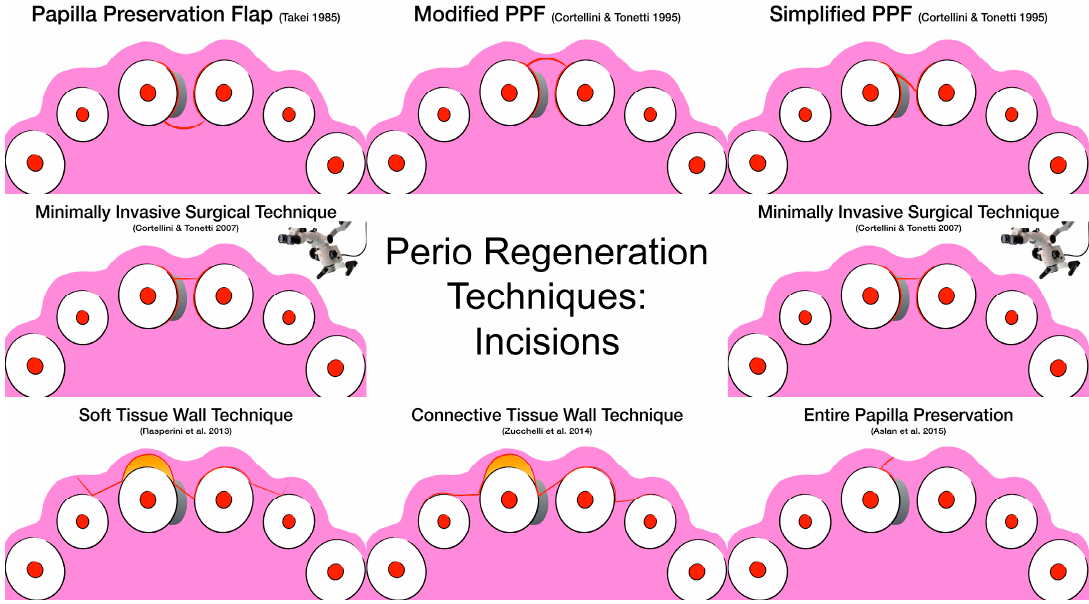
Figure 2. Visual representation of the surgical incisions according to surgical technique.